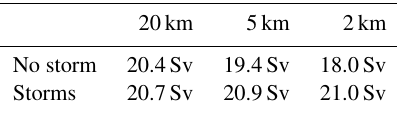
Table 2. Maximum of the clockwise cell (as in the context of Fig. 7) of the overturning streamfunction ψ iso (Sv) averaged be- tween y = 2000km and y = 2500km. The streamfunctions have been computed using 10 years of 5-day average outputs from equi- librated experiments. Model transports have been multiplied by 10 in order to scale them to the full Southern